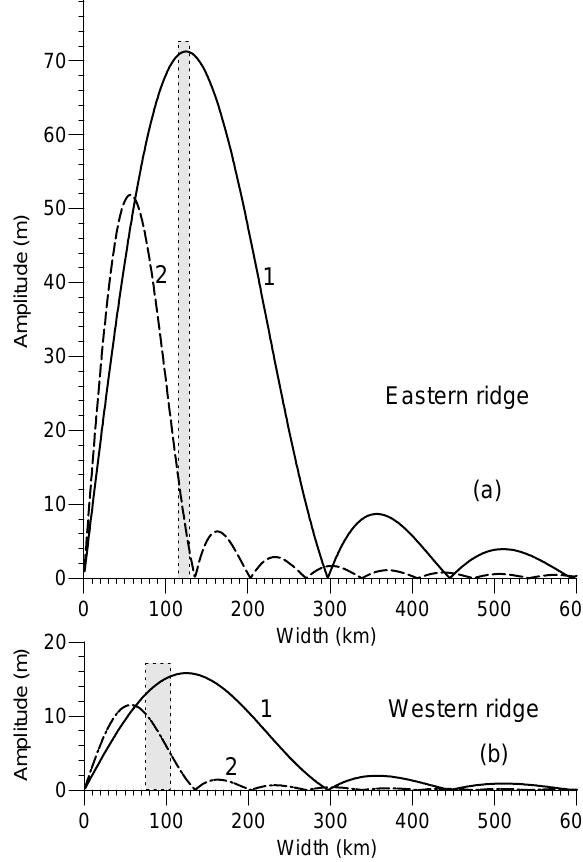
Fig. 13. Wave amplitudes of two first baroclinic modes (solid and dashed lines, respectively) generated by the eastern (a) and west- ern (b) ridges, as predicted by linear theory. The uncertainty in definition of the ridge width is shown by grey